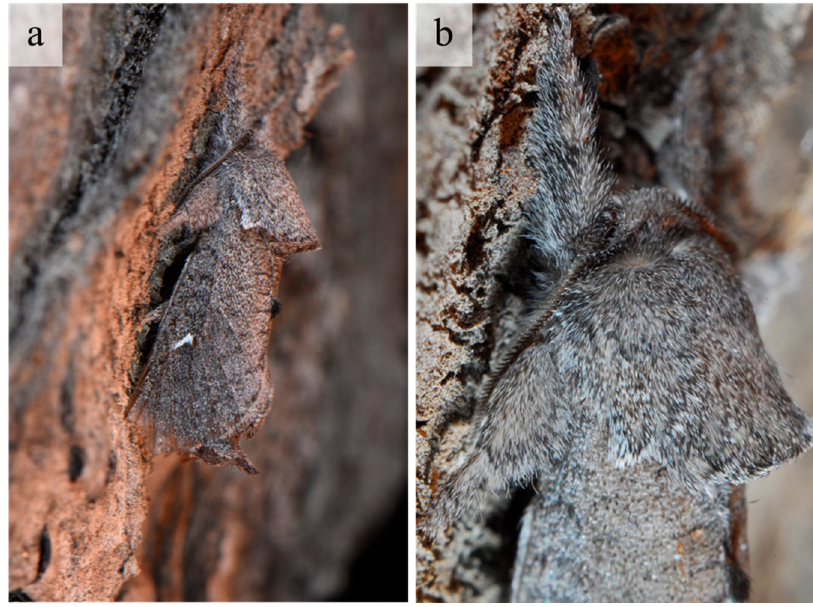
Figure 2. Givira ethela adult. ( a ) On the vine bark; ( b ) Head and prothorax magnification.